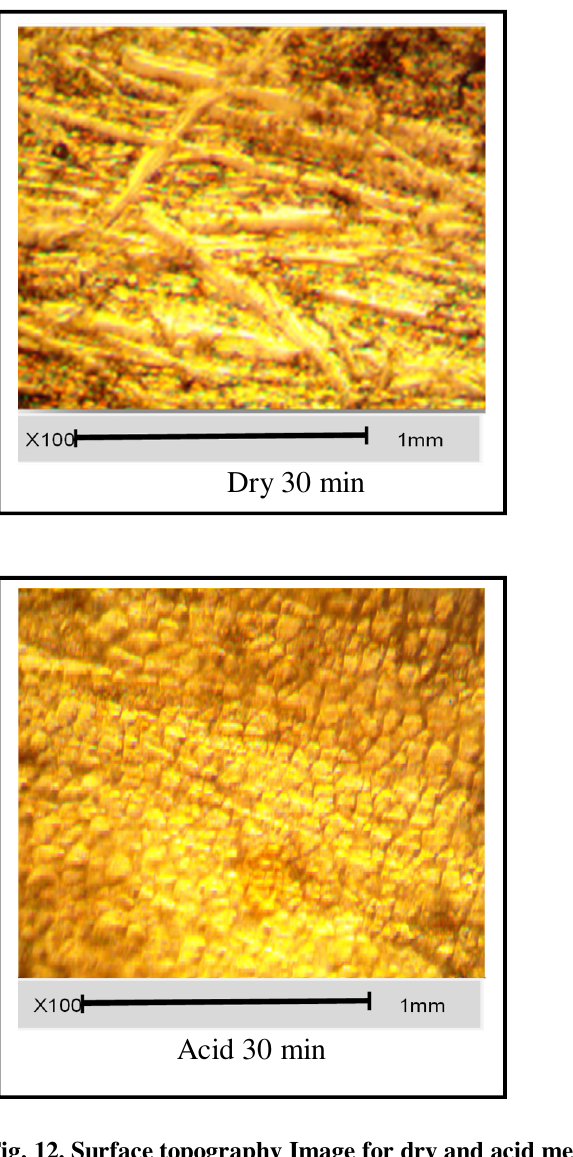
Fig. 12. Surface topography Image for dry and acid mediums